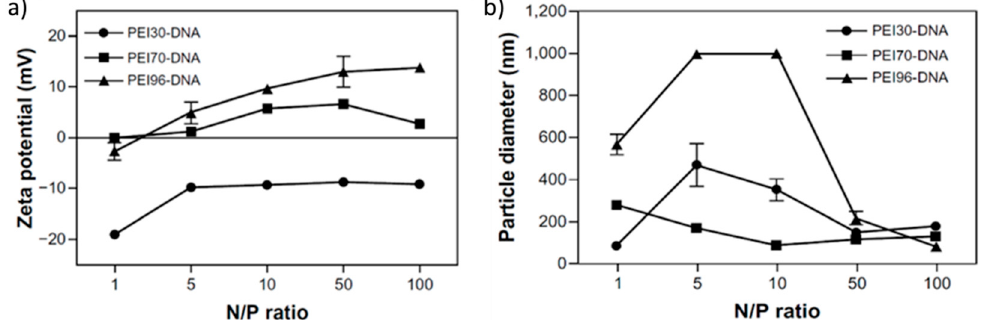
Figure 7. ζ potential ( a ) and size ( b ) variations of polyplex particles formed from PEtOx–PEI of DP 100. The copolymer concentration was 10 mg / mL. Adapted from Fernandes et al. as published copolymers of DP 100. The copolymer concentration was 10 mg/mL. Adapted from Fernandes et al. by the Dovepress as published by the Dovepress [47].